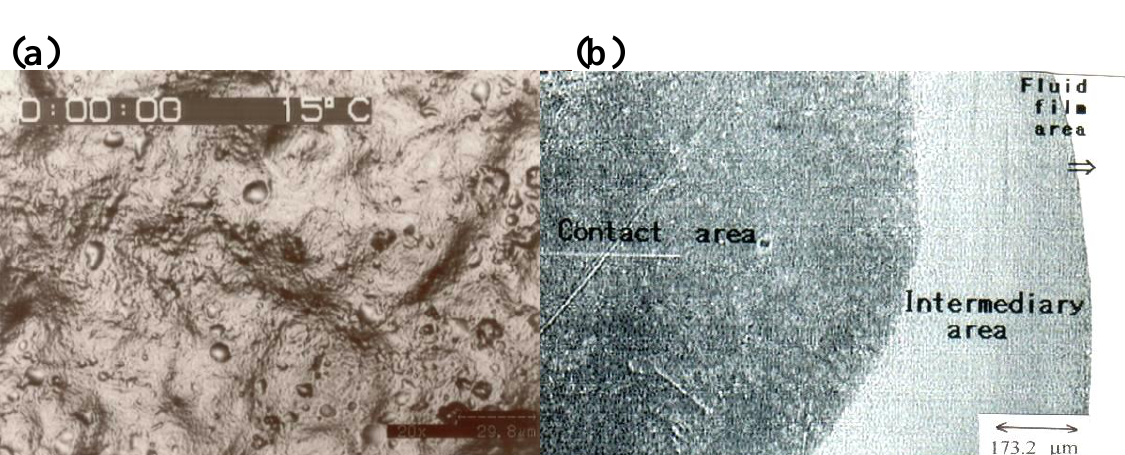
Figure 8. CLSM image of normal articular cartilage surface of rabbit femoral condyle of knee joint. (a) Normal articular cartilage surface has a lot of depressions and drops of the synovial fluid without loading. (×1,400). (b) CLSM image of normal articular cartilage surface under the loading